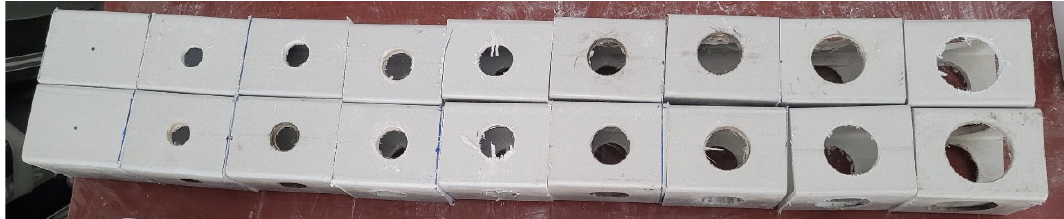
Figure 2. Specimens with different opening sizes. Table 2. Material properties of FRP